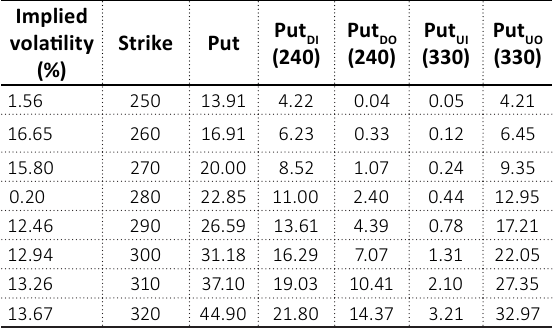
Table 7. European put/put barrier option premiums with barrier levels 240 and 330